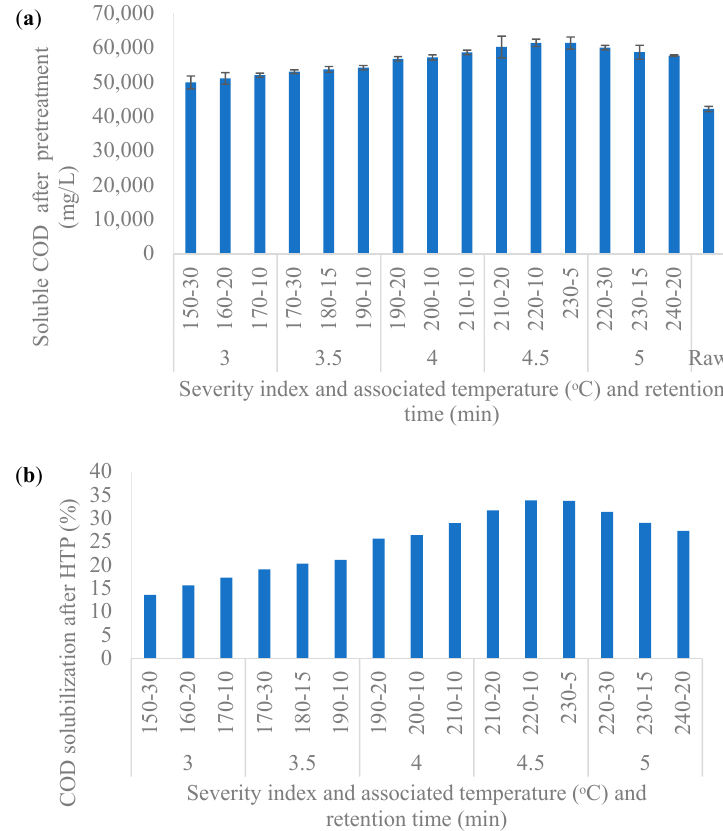
Figure 1. Effect of HTP on the soluble content of SSO: ( a ) Concentration of soluble chemical oxygen demand (COD) after HTP; ( b ) COD solubilization after HTP.